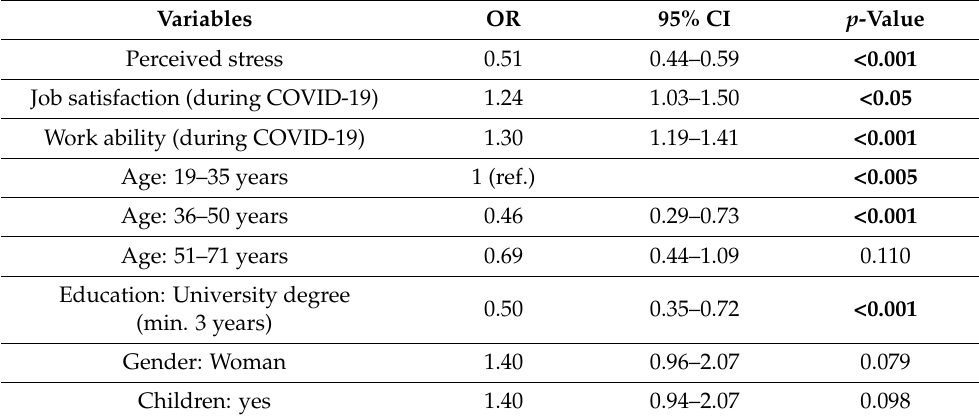
Table 4. Data of the binary logistic regression analysis conducted to predict a Warwick–Edinburgh Mental Well-Being Scale mean score above or below 44. Variables OR 95% CI p -Value Perceived